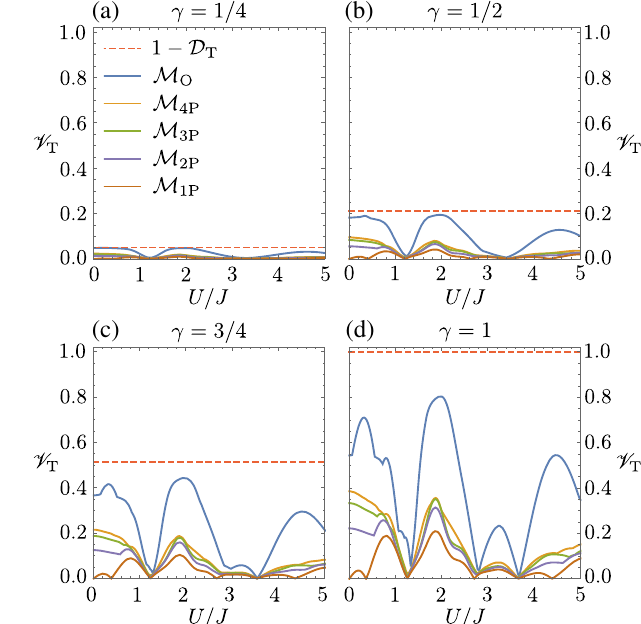
FIG. 7. Many-particle interference visibility V T in the double- well Bose-Hubbard model (78) for the particle occupation measurement M O and tilt F ¼ 0 . Panels (a) – (d) show the visibility V T as a function of the evolution time t for different levels of particle distinguishability in the internal state (79), as controlled by γ ¼ 1 = 4 , 1 = 2 , 3 = 4 , and 1, respectively. Independ- ently of the interaction strength U=J , and as predicted by Eq. (65), the visibility V T is bounded for all evolution times t by the particle indistinguishability 1 − D T (red dashed line), which is a monotonously increasing function of γ , as illustrated in the inset of panel (a).